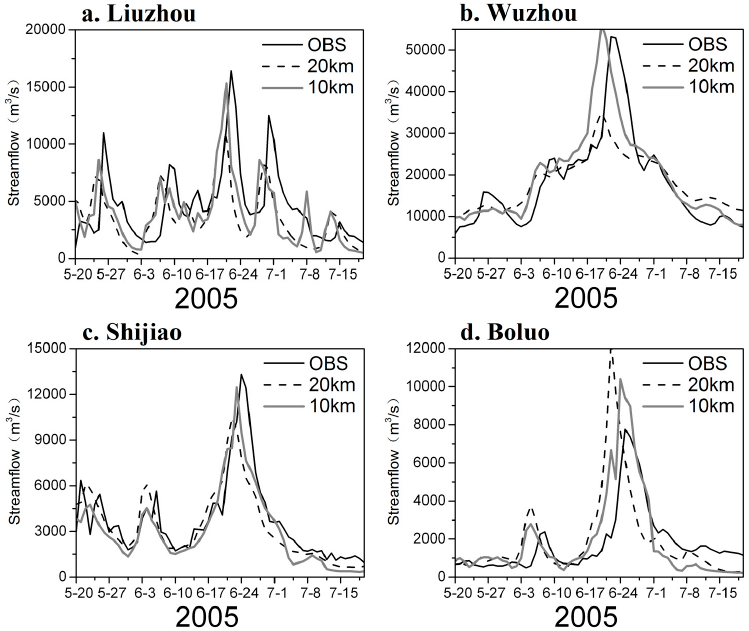
Figure 5. Flood simulation results at ( a ) Liuzhou; ( b ) Wuzhou; ( c ) Shijiao; ( d ) and Boluo Stations in the Pearl River in 2005.